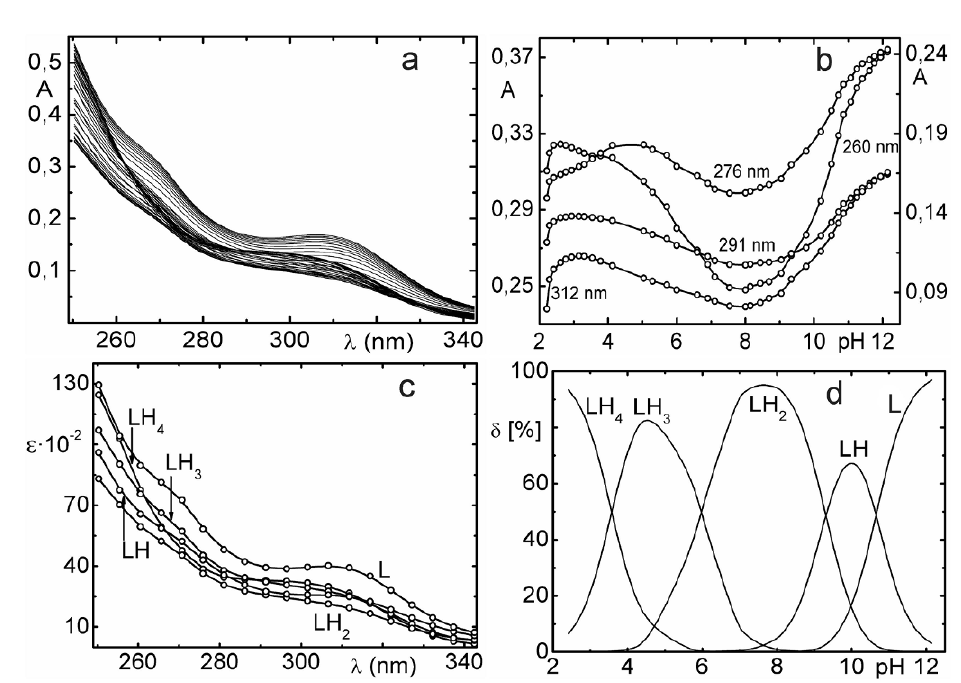
Figure 4. (a) Absorption spectra of 4.2 · 10 -5 mol · dm -3 vardenafil in dependence on pH at 25ºC , (b) The absorbance vs. pH curves for 260 nm, 276 nm, 291 nm and 312 nm at 25ºC,(c) Pure spectra profiles of molar absorptivity vs. wavelengths for the variously protonated species L, HL, H L, H L, and H L, (d) Distribution diagram of the relative concentrations of all variously protonated species L, HL, H 2 3 4 H